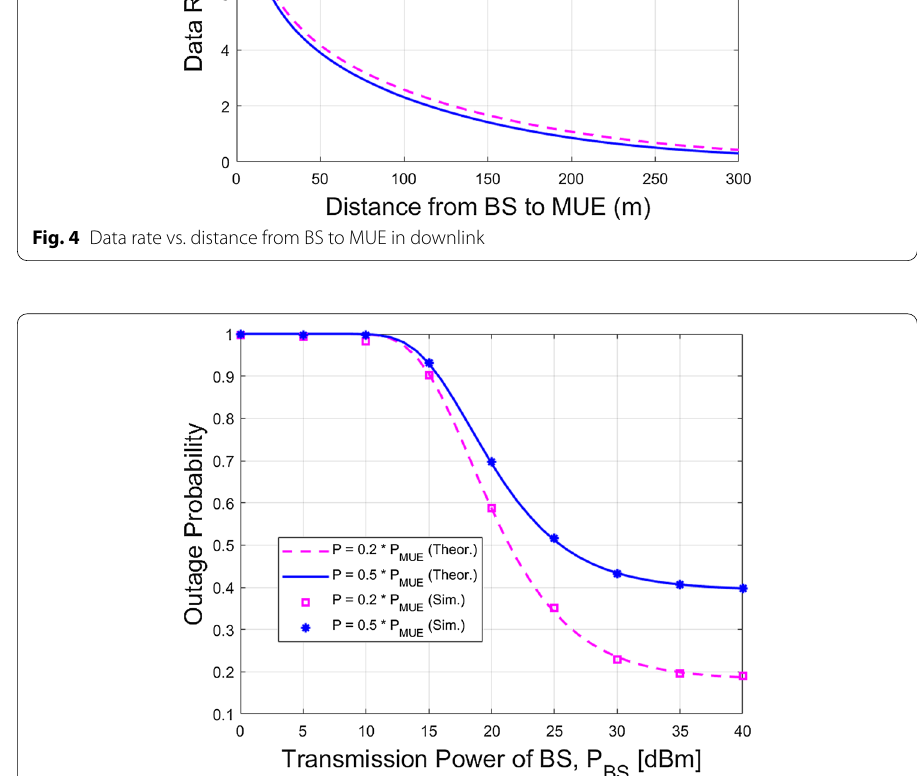
Fig. 5 Outage probability vs. transmission power of BS in